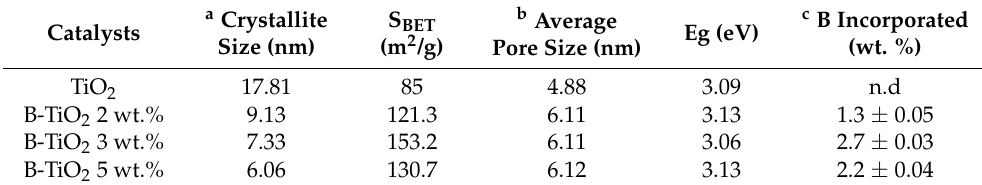
Table 1. Characterization results for TiO 2 and B-TiO 2 catalysts.